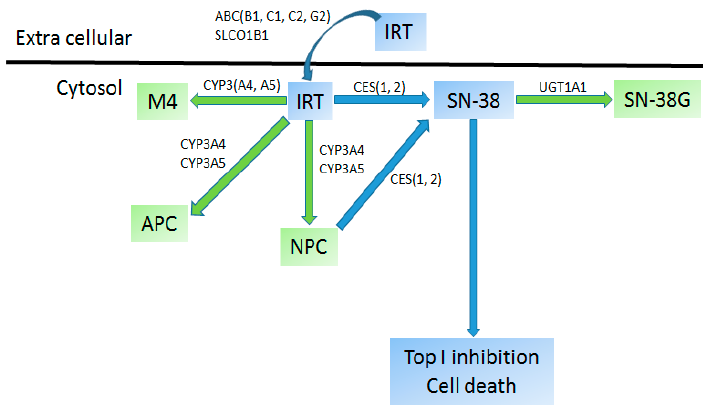
Figure 5. Metabolism of Irinotecan. Metabolites: Ethyl-10-[4- N -(5-aminopentanoic acid)-1-piperidino] carbonyloxycamptothecin (APC), Irinotecan (IRT), 7-ethyl-10-[4-(1-piperidino)-1-amino] carbonyloxycamptothecin (NPC), 7-Ethyl-10-hydroxy-camptothecin (SN-38), 7-Ethyl-10-hydroxy- camptothecin glucoronic acid (SN-38G), Irinotecan metabolite M4 (M4). Enzymes: ATP binding cassette subfamily B1, C1, C2, G2 (ABCB1, ABCC1, ABCC2 and ABCG2), carboxylesterase 1, 2 (CES1, CES2), Cytochrome P450 3A4, 3A5 (CYP3A4, CYP3A5), Solute carrier organic anion transporter family member 1B1 (SLCO1B1), UDP glucuronosyltransferase family 1 member A1 (UGT1A1). Colors: blue—prodrug, drug or effect; green—inactive metabolites (adapted from [22]).